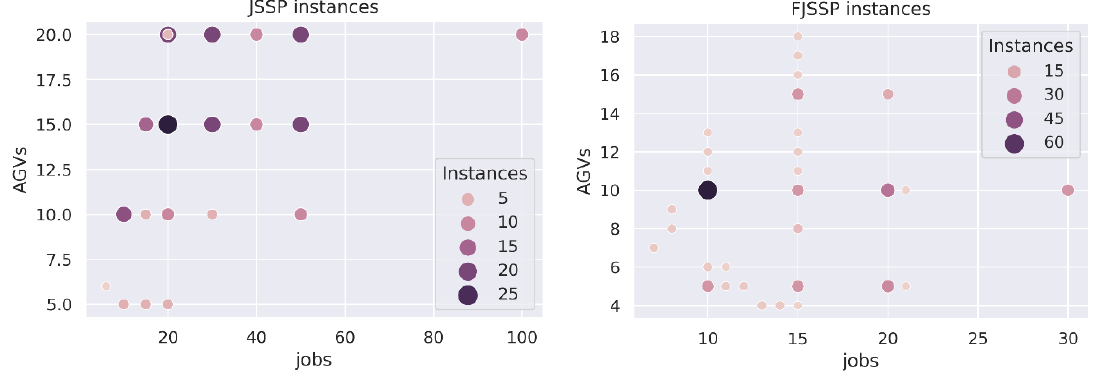
Figure 3. Distribution of jobs and AGVs in benchmark instances.